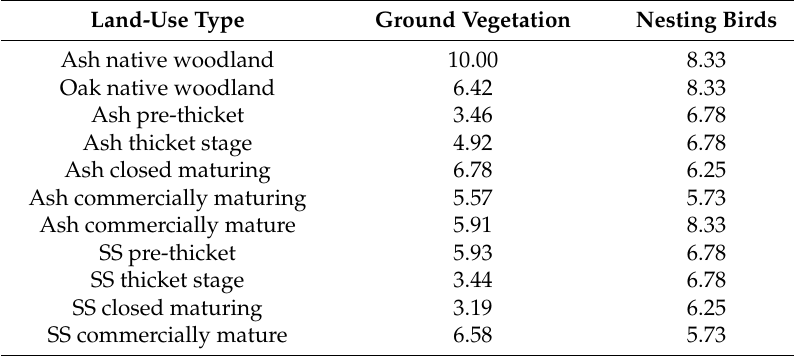
Table A5. Scaled SR scores for ground vegetation and nesting birds during the breeding season. Source: